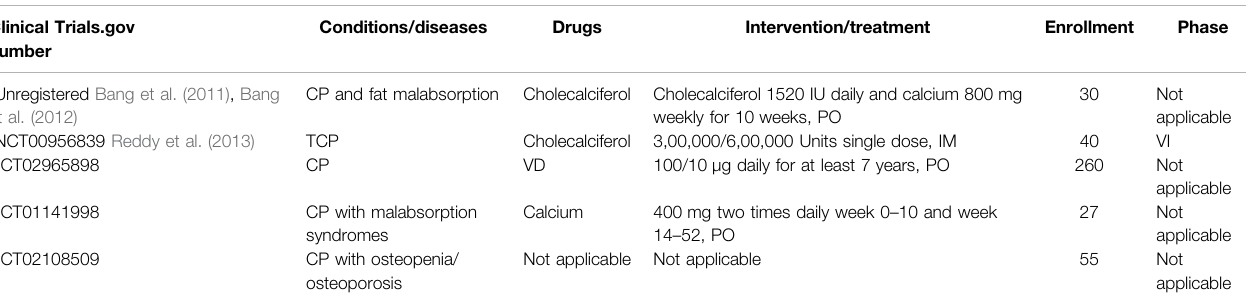
TABLE 4 | Clinical trials (http://clinicaltrials.gov/). Clinical Trials.gov